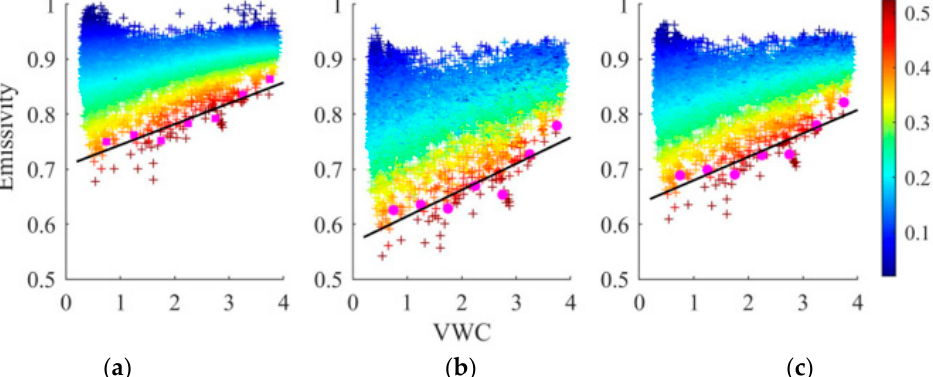
Figure 3. Minimum surface emissivity for vertical ( a ), horizontal ( b ) and combined vertical and horizontal ( c ) polarization at different VWC levels based on the ascending SMAP dataset. The color of ‘+’ indicates the change in SSM. The pink circles represent e MIN calculated for each VWC interval. The black solid line is the fitted linear relationship between e MIN and VWC.